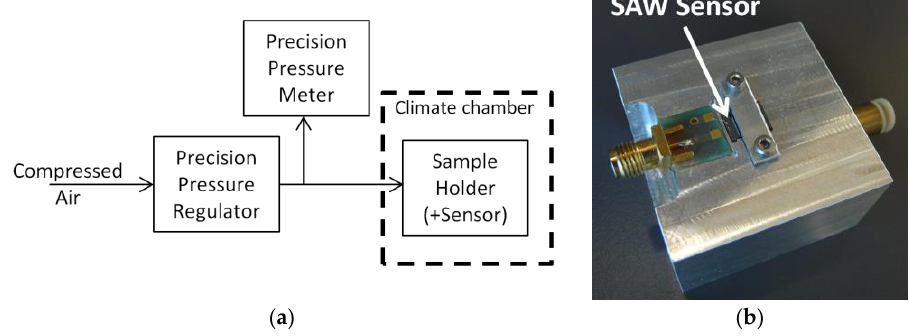
Figure 6. Test Set-Up: ( a ) Set-Up schematics; ( b ) Sample holder.